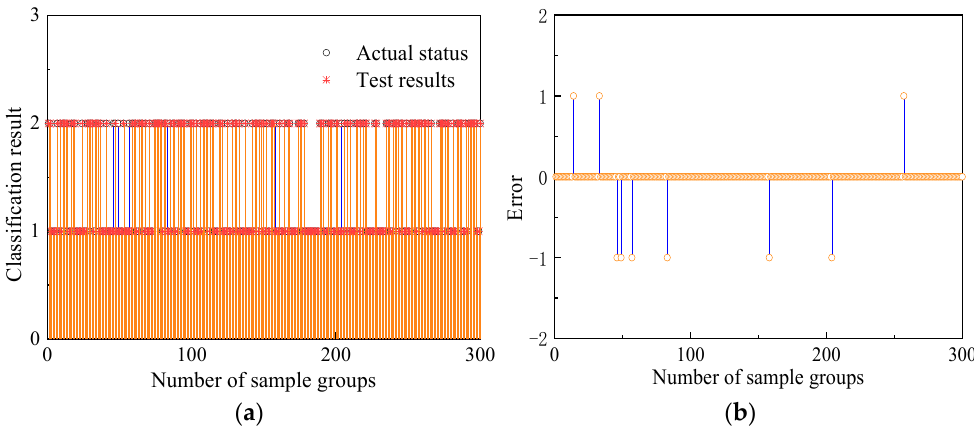
Figure 7. IPNN training effect diagram: ( a ) IPNN training data classification results; ( b ) IPNN training data detection error.